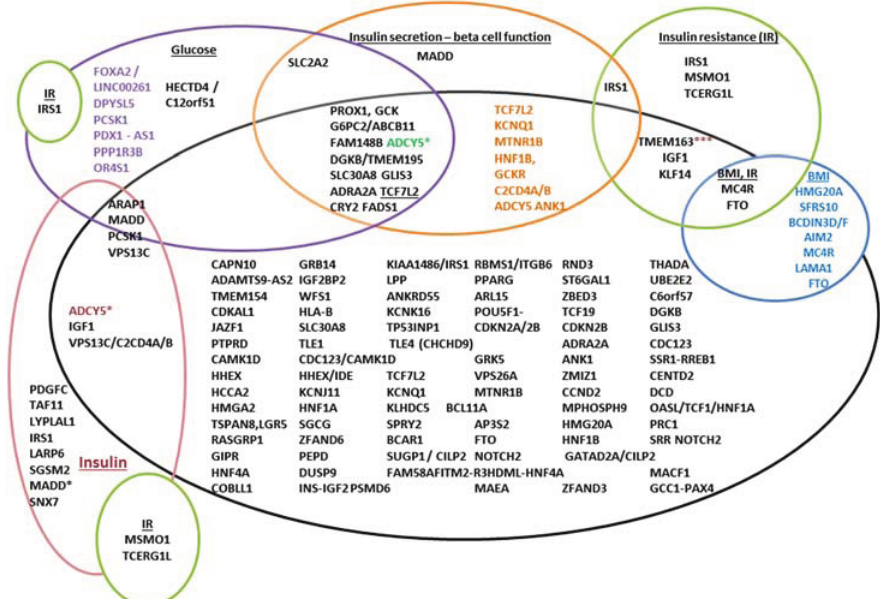
Figure 3. T2D and glycemic trait associated variants. The variants are represented by gene names here, which could indicate that the location is present either in the gene, or in the vicinity of the gene. The black circle represents T2D, and the gene names in black in this represent variants only associated with T2D. The overlapping circles indicate additional reporting associations for that variant for instance, TCF7L2 , KCNQ1 , MTNR1B etc. , are associated with T2D and also with beta-cell dysfunction. An ADCY5 variant is associated with 2 h insulin adjusted for 2 h glucose; 2 h glucose/T2D (in brown) *** variants in TMEM163 are also associated with fasting insulin, TCF7L2 —associated with fasting and 2 h glucose and MADD variants associated with fasting proinsulin, fasting glucose and